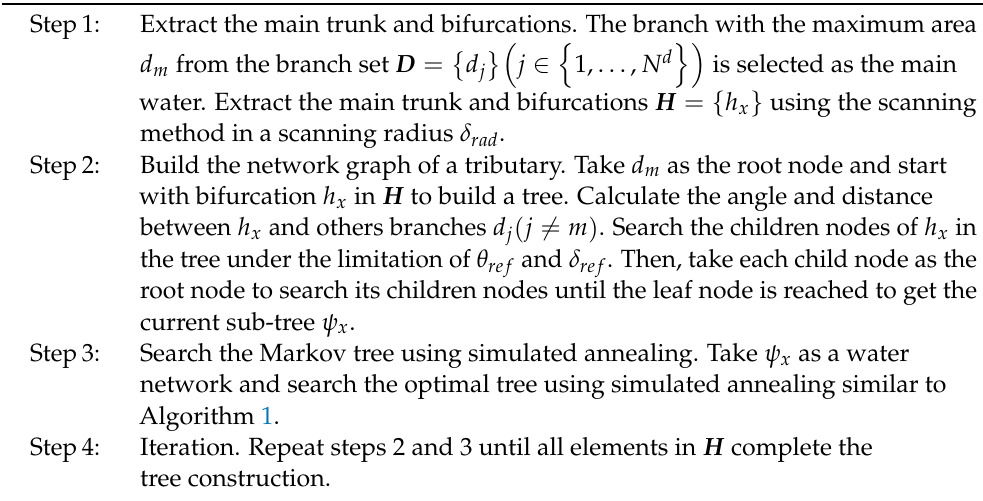
Algorithm 2: Water network construction based on Markov tree in local